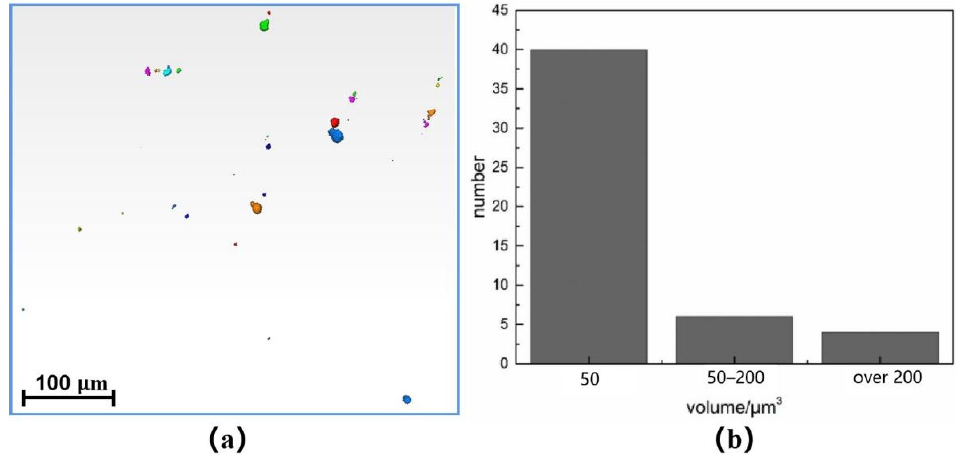
Figure 10. ( a ) Top view of imaging area, ( b ) statistical diagram of defect volume